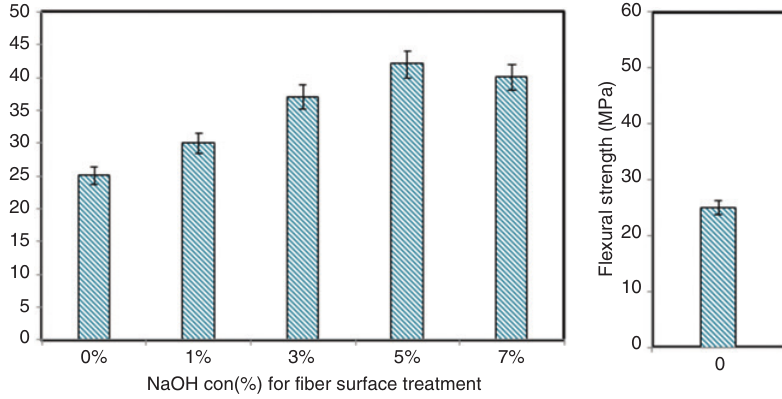
Figure 5: Flexural strength of the double-layer 0-, 2-, 4-, and 6-h alkali-treated LCF epoxy